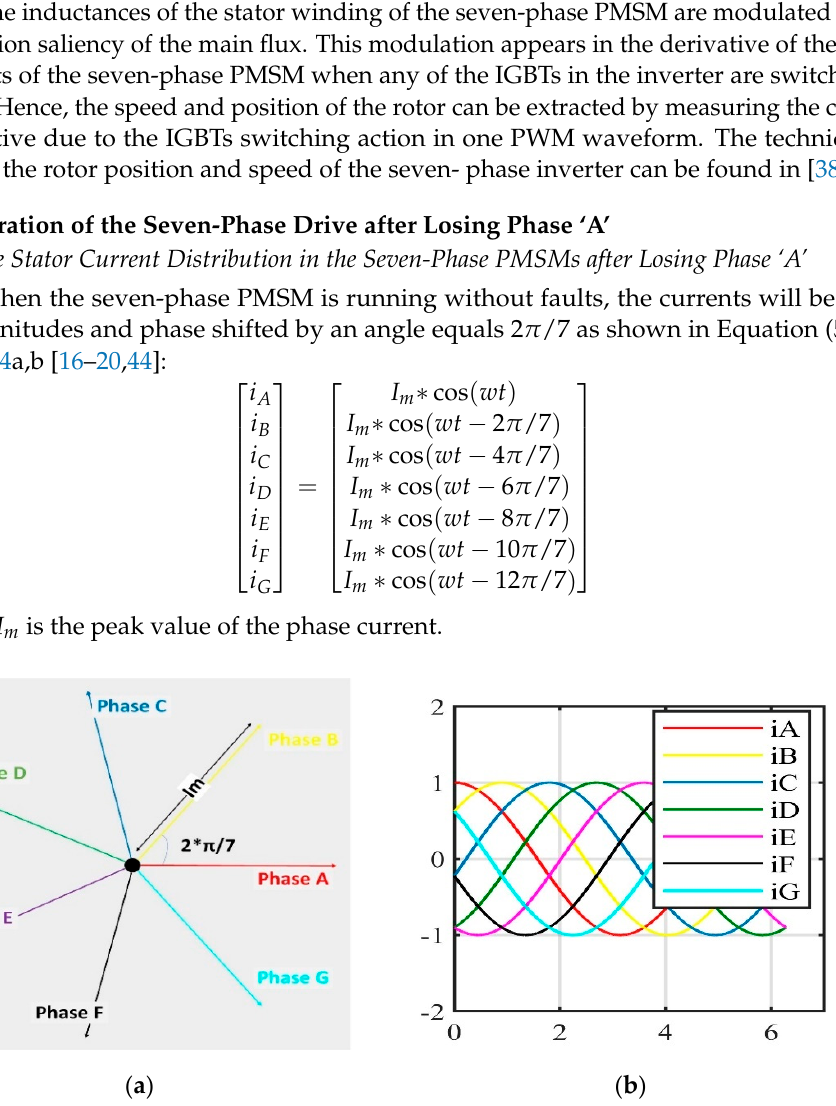
Figure 4. Current distribution of seven ‐ phase motor under normal operating condition ( a ) Phasor; ( b ) sinusoidal.